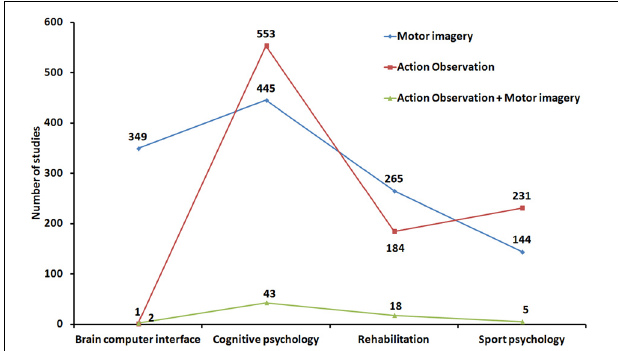
FIGURE 2 | Percentage of AO, MI, and AO + MI studies in the four pre-determined research